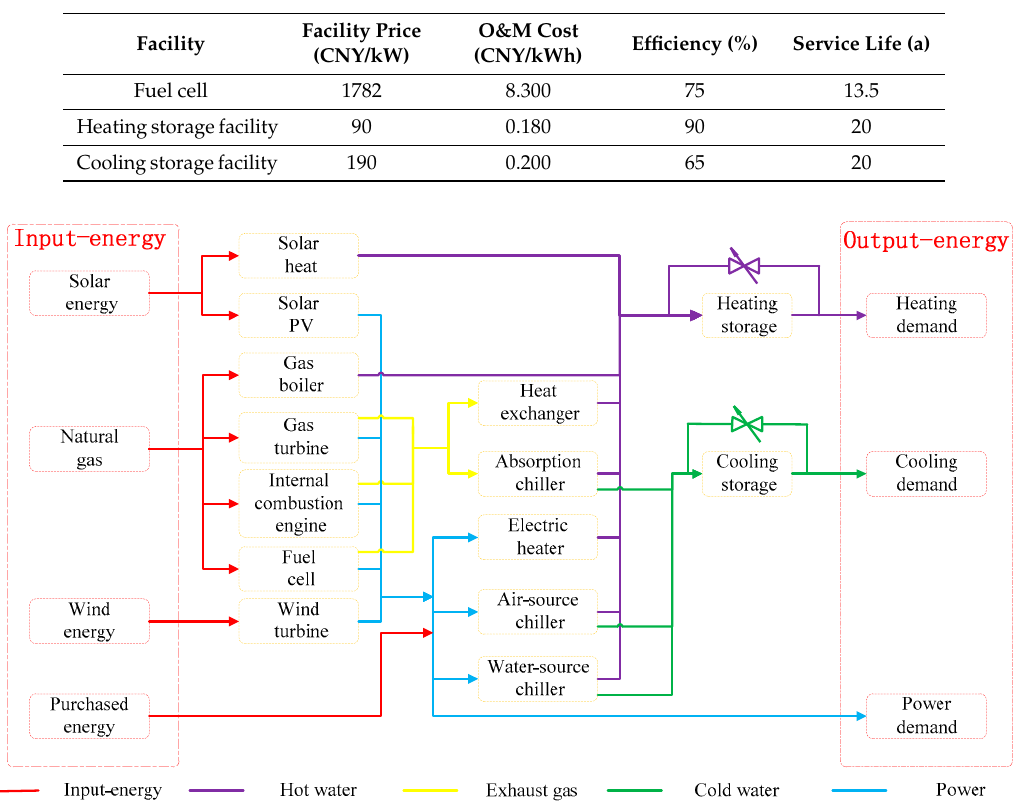
Table 3. Parameters of energy storage facility.